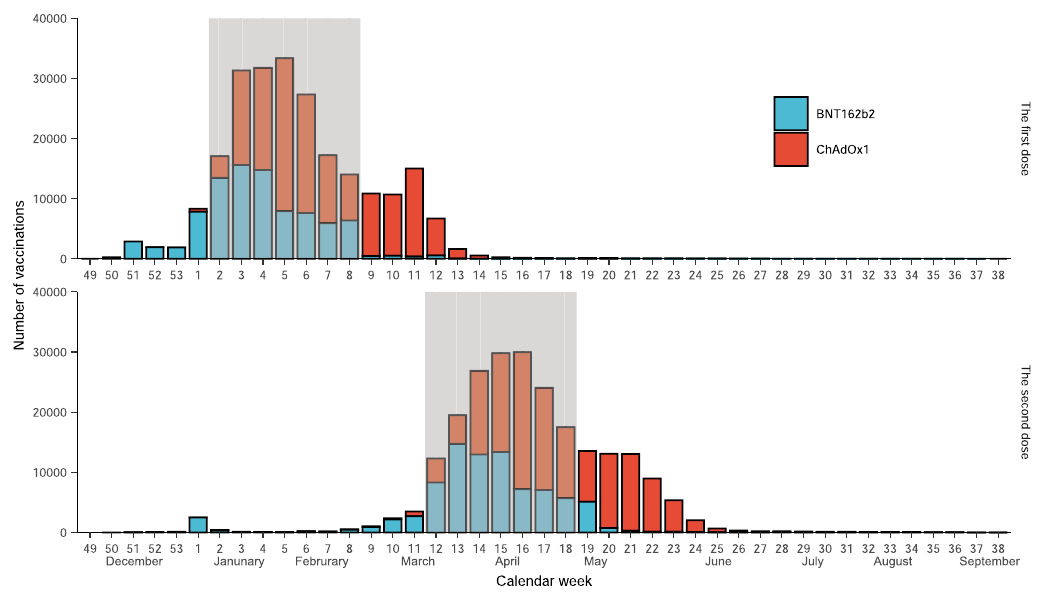
Fig. 1 The number of people receiving either BNT162b2 or ChAdOx1 Covid-19 vaccine in the study cohort from Dec 01, 2020 to Sep 21, 2021. The rectangle background with grey colour depicts the vaccination anchor windows. Only people who received study vaccines within the anchor windows were included for the comparative analysis. We de fi ned the 2rd to 8th (Jan 11, 2021 to Feb 28, 2021) and 12th to 18th (March 22, 2021 to May 9, 2021) calendar weeks as the two anchor windows for the one-dose and two-dose cohorts, respectively. The decision-making for these anchor windows was based on (1) there were both BNT162b2 and ChAdOx1 vaccines delivered in each epidemiological week of the window, (2) numbers of the two vaccines were generally comparable, and (3) UK ’ s policy on the gap between the fi rst and second dose was 10 to 12 weeks for both vaccines.